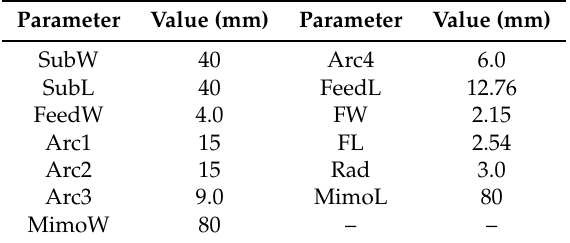
Figure 1. Proposed wideband multiple-input multiple-output (MIMO) antenna geometric layout. Table 1. Proposed wideband antenna element